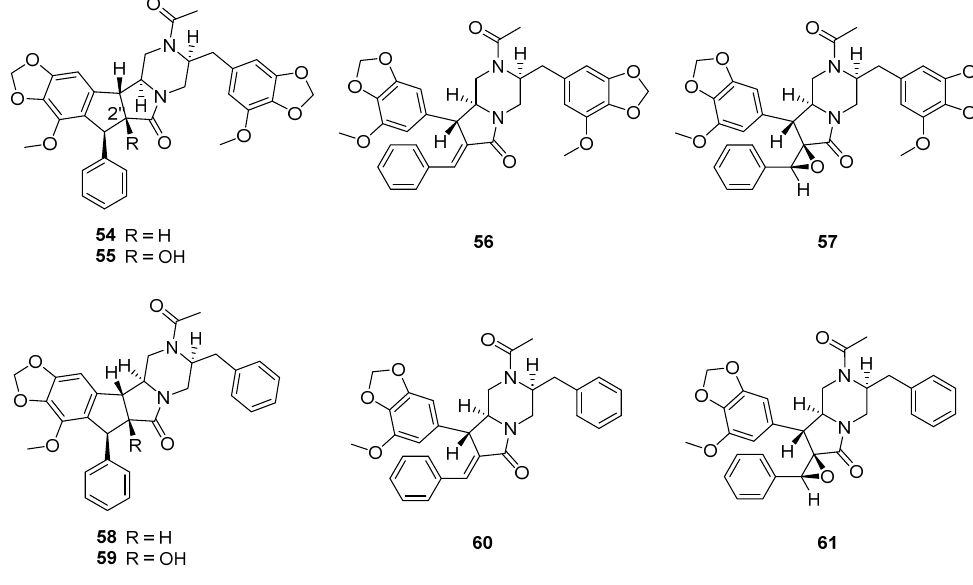
Figure 11. Structure of alkaloids 54 – 61 [55].